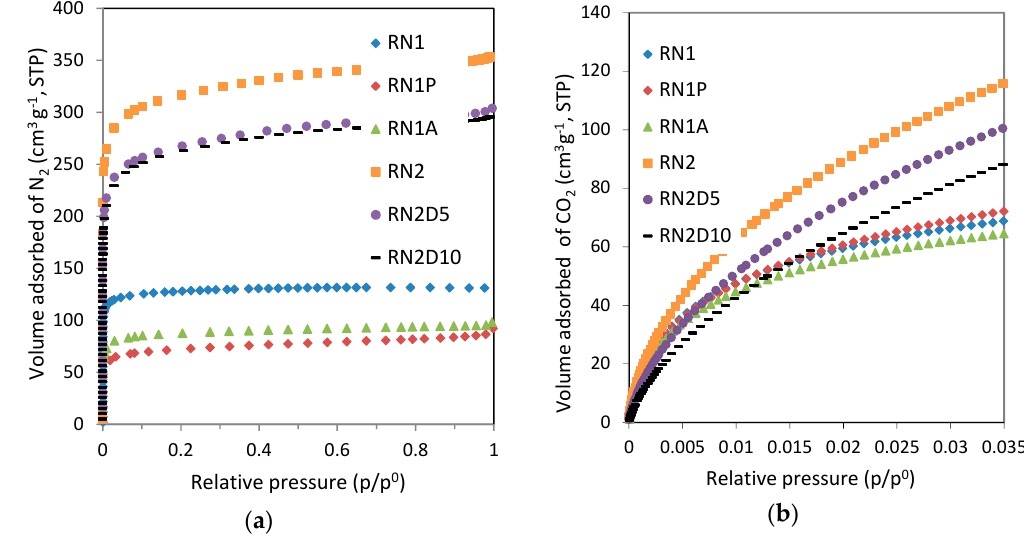
Figure 1. Adsorption isotherms of the prepared carbons: ( a ) N 2 at − 196 °C and ( b ) CO 2 at 0 °C.